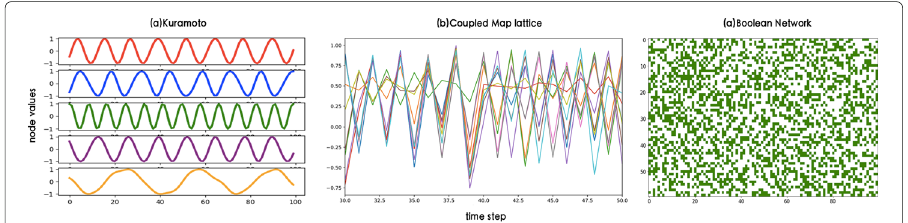
Fig. 4 Time evolution of node values in three types of network simulations models. Kuramoto (a), Coupled Map Lattice (b) and Boolean Network